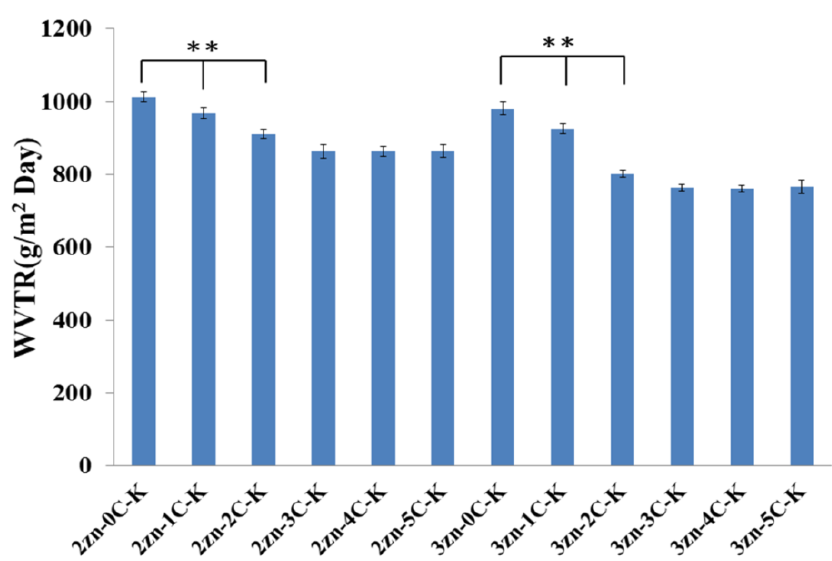
Figure 4. Water vapor transmission rate of functional antibacterial knitted fabrics as related to twist coefficient. Note: data shown as mean standard deviation (SD) ( n = 3). ** p < 0.01.